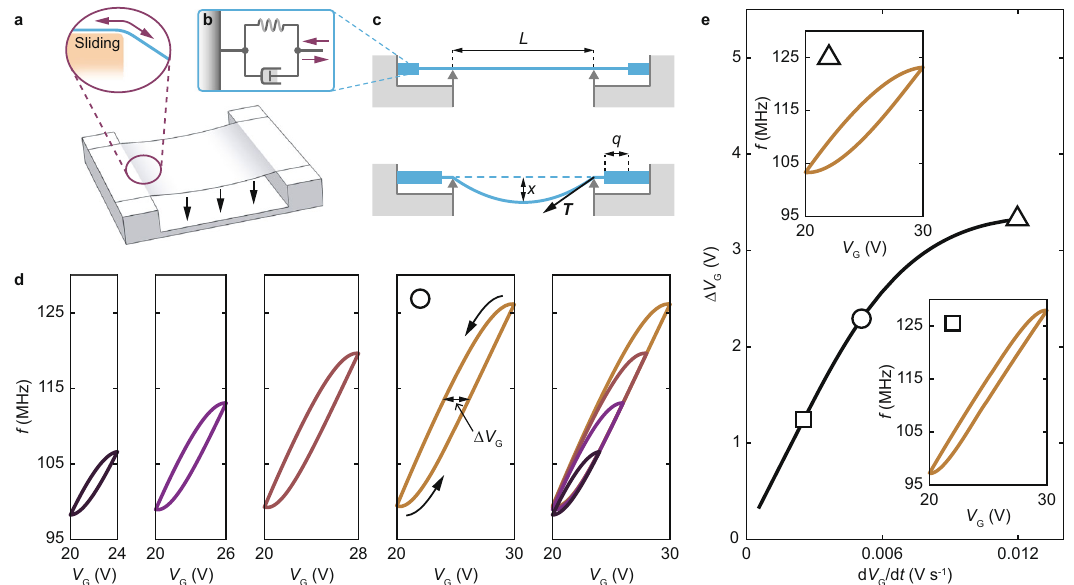
the membrane away from the suspended area, shortening the resonator and increasing f . d Calculated f as a function of V G for different V G ranges. Arrows indicate the path followed by f ð V G Þ . The rightmost panel in d displays the super- imposed frequency loops shown in the four leftmost panels. e Calculated width of frequency loop 4 V G as a function of d V G = d t . Marker shape identi fi es the data set ( d and insets to e ) from which 4 V G is